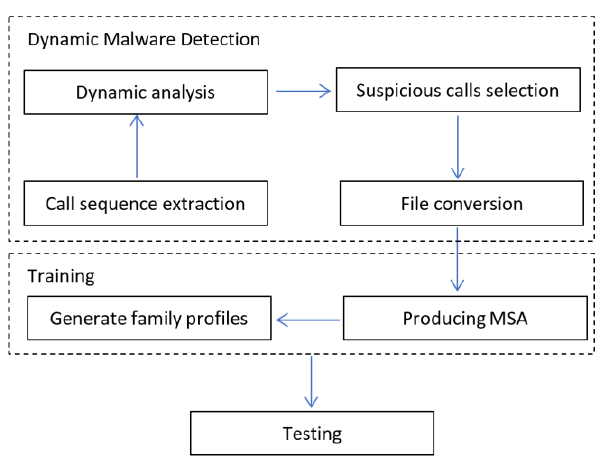
Figure 1. Main components of DIP which include dynamic malware detection, training and testing.